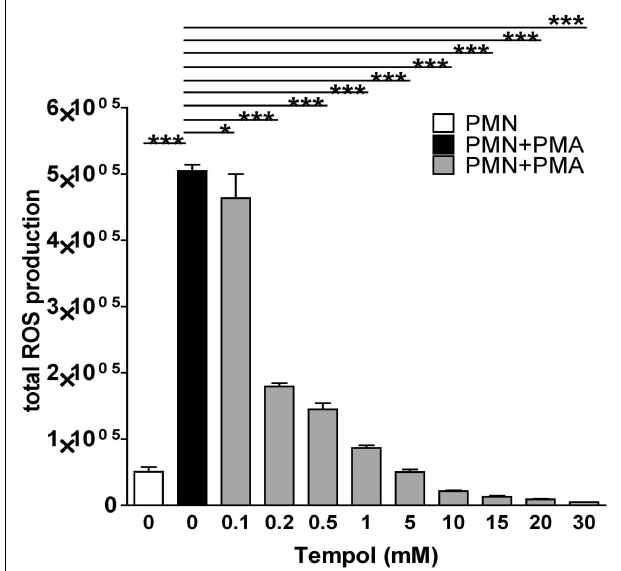
FIGURE 2 |Tempol scavenges neutrophil ROS triggered by PMA. The total amount of ROS generated by PMNs over the course of three 3h is plotted against increasing concentrations ofTempol.The half maximal inhibitory concentration (IC50) is 0.2mMTempol. ROS amounts were calculated as area under the curve (AUC).White bar: unstimulated PMNs, black bar: PMNs stimulated with 100nM PMA, grey bars: PMNs treated with different concentration ofTempol prior to stimulation with PMA. Significance was analyzed byTukey one-way ANOVA (* P ≤ 0.05 and *** P ≤ 0.001). One representative experiment out of three independent experiments with three different donors is shown. Data are presented as means of three technical replicates ± SD.